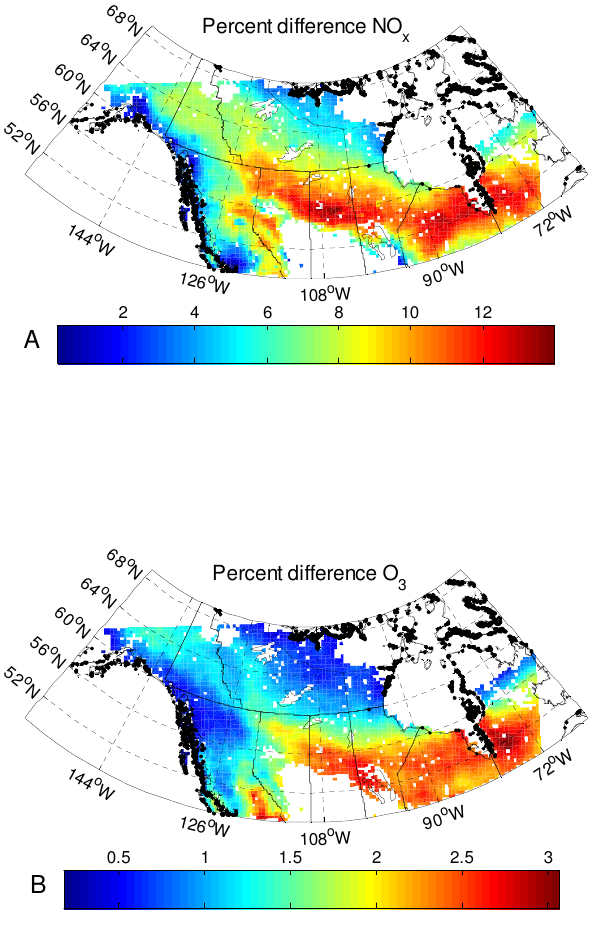
Fig. 10. Percent differences ((RECYCLE − BASE)/BASE × 100) Figure 10 Percent differences ((RECYCLE-BASE)/BASE×100) between the RECYCLE and 3 between the RECYCLE and BASE cases for the 24h, boundary- BASE cases for the 24 h, boundary layer averaged a) NO x and b) O 3 concentrations. 4 layer-averaged (a) NO x and (b) O 3